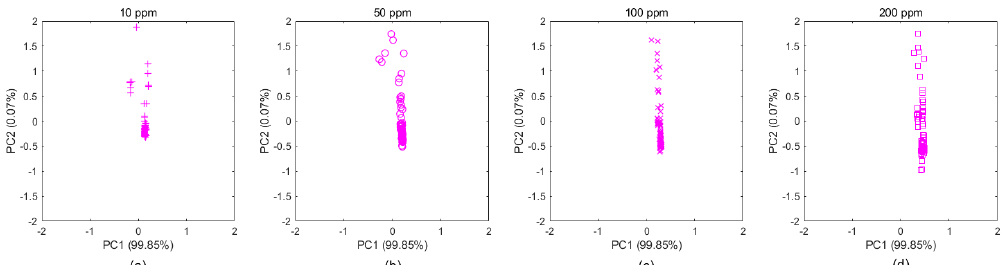
Figure 5. Example of the new data transformed by the Maximum Independence of the Concentration Features (MICF) in Batch 10. The Figure 5a–d show that the new ethylene data, transformed from the original data by the MICF, is projected into two dimensional subspaces, whose basis is two principal components computed by PCA. The drift interference caused by concentration was suppressed, so the data distributions tended to be consistent.